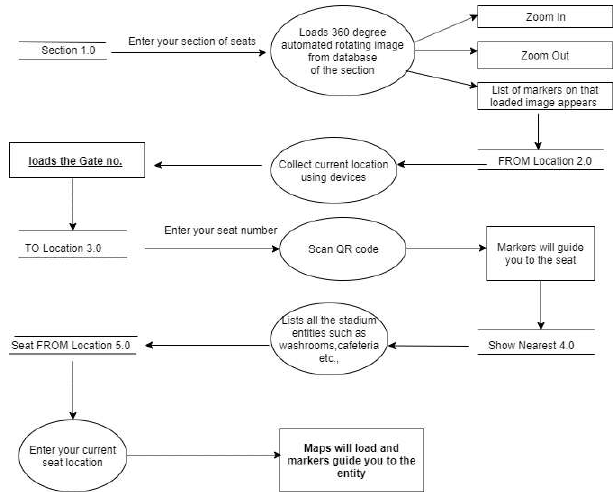
Figure 3. Data Flow Diagram.